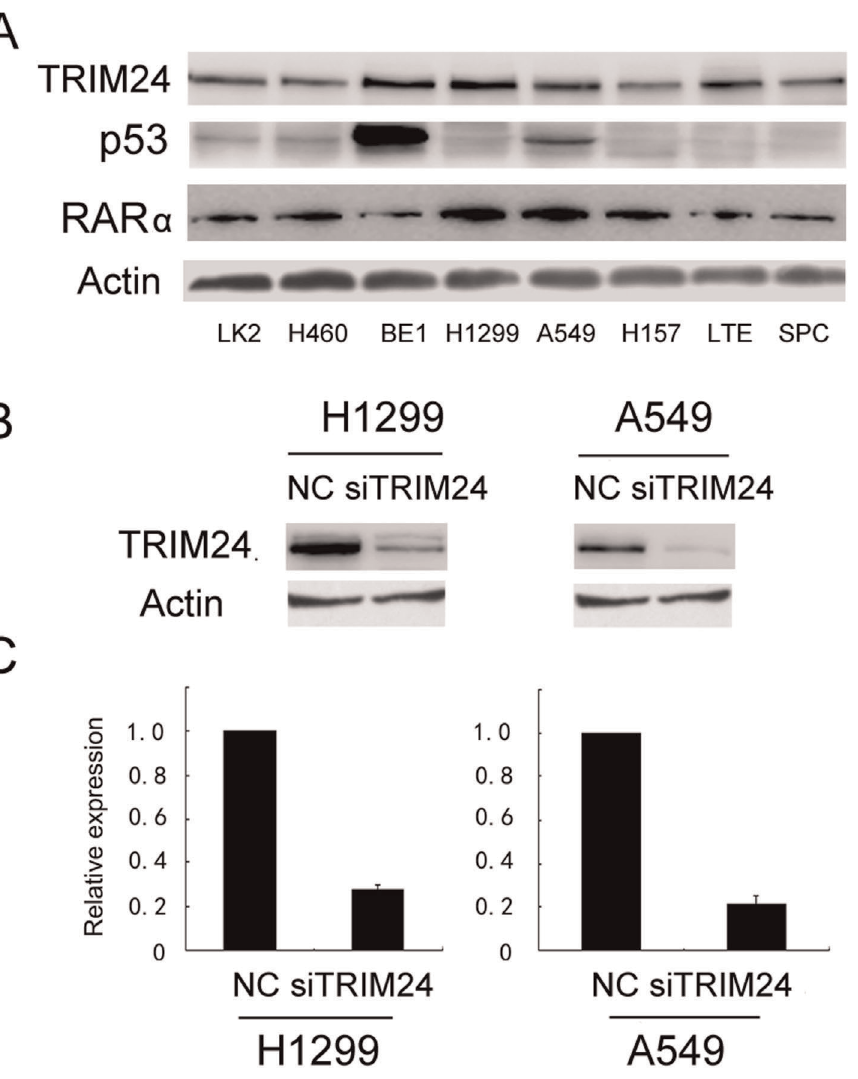
Figure 3. TRIM24 depletion in A549 and H1299 cell lines. A. Expression levels of TRIM24, p53 and RAR a were analyzed by western blot in a panel of lung cancer cell lines. B. Western blot of TRIM24 depletion efficiency in cancer cells. C. Real-time PCR analyses of TRIM24 depletion efficiency in cancer cells.